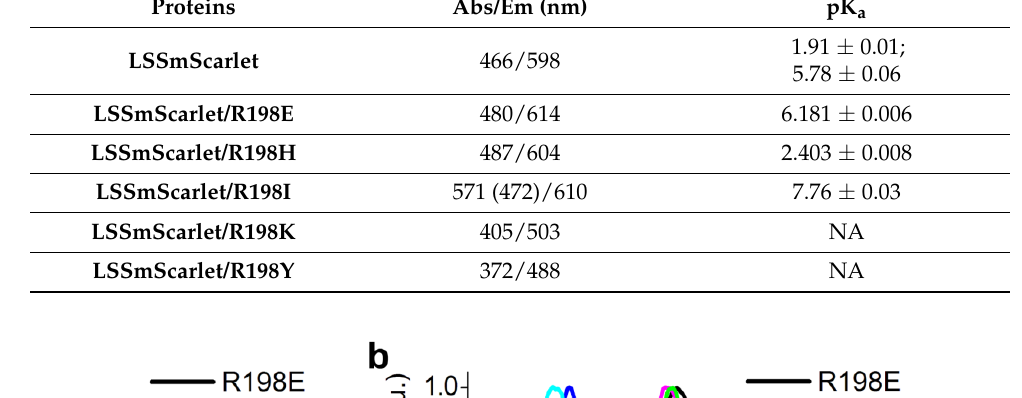
Table 4. In vitro properties of the LSSmScarlet and its mutants at 198 position. Minor peaks are shown in parentheses. Standard deviations are shown. NA, not applicable.